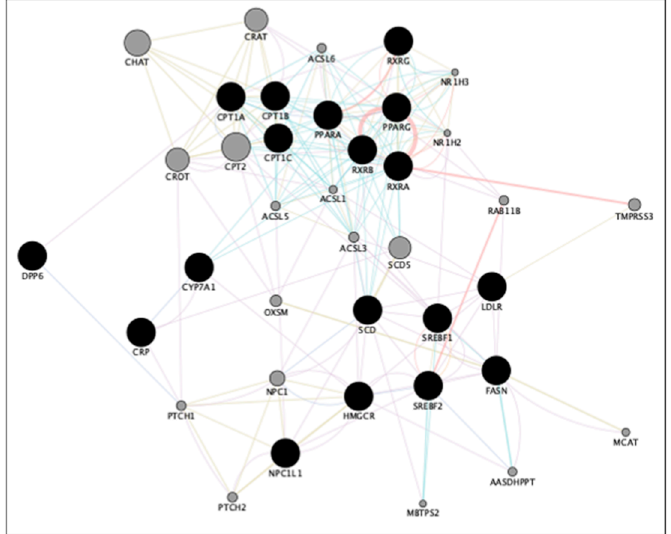
Figure 4. Functional network of genes associated with cardiovascular disease and legumes proteins. Black nodes denote query genes; gray nodes denote attribute